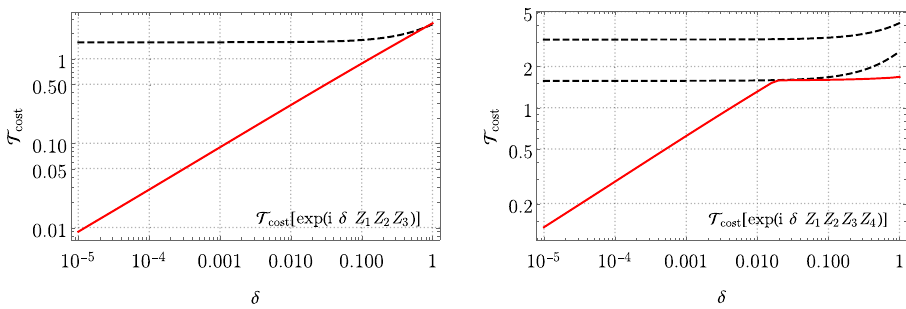
Fig. 1 Gate decomposition cost T cost for decomposing exp ð i δ Z (cid:3) 3 Þ (left) and exp ð i δ Z (cid:3) 4 Þ (right), for δ ∈ [10 − 5 , 1]. The lower dashed line is the cost obtained by conjugation decomposition, π /2 + δ . The upper dashed line is the cost for a once-nested conjgation, π + δ . Decomposing the four-local gate with an outer depth-5 and an inner depth 4 formula according to Eqs. (11) and (12) only saturates the lower conjugation